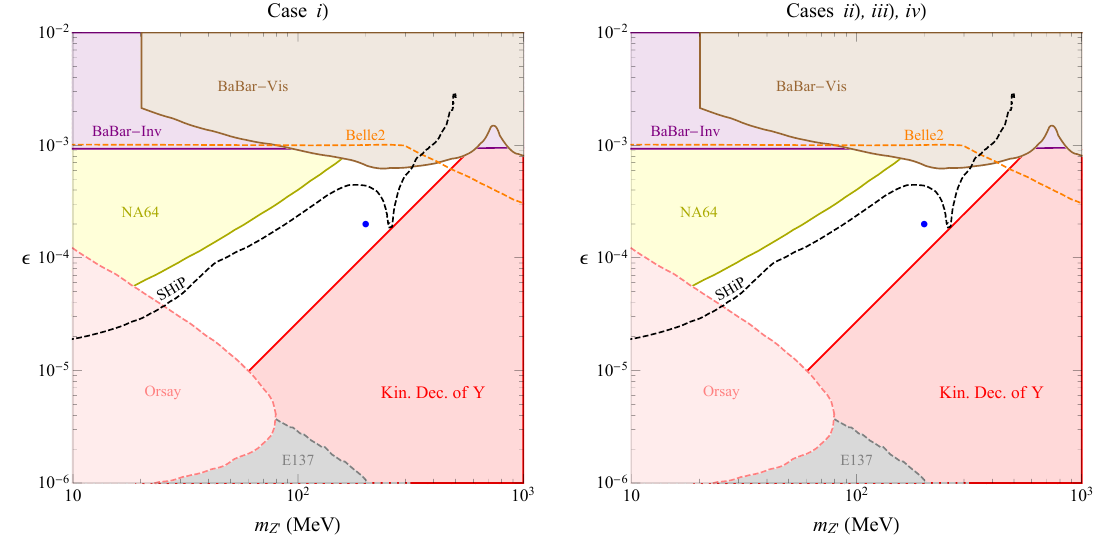
Figure 1 . Kinetic decoupling and Z 0 -search constraints for the case i) (left) and cases ii) , iii) , and iv) (right) in the ( m Z 0 , (cid:15) ) plane. See the main text in section 3.2 for details of the used constraints. We have the same plot for ii) , iii) , and iv) since the same m we do not see a clearly visible difference between the left and right plots since the difference in m is small. The blue points represent our benchmark cases shown in table